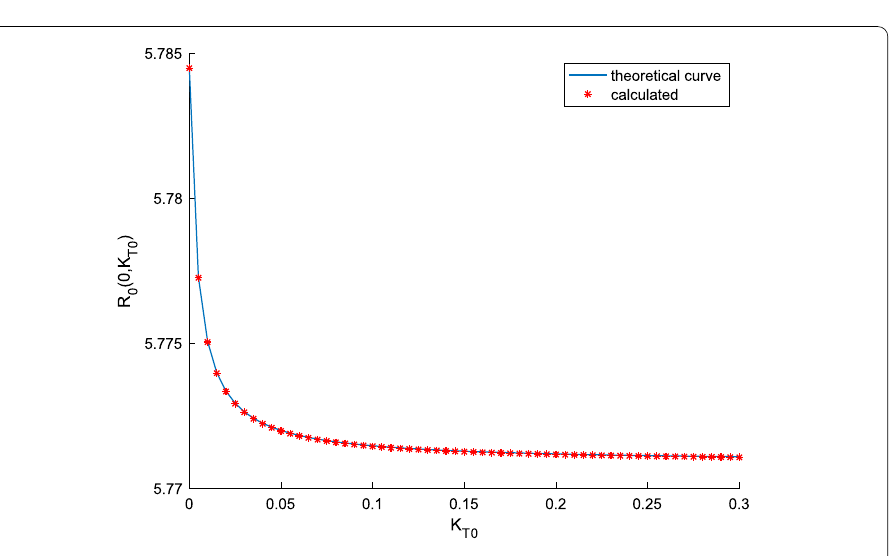
Figure 18 Variation of the basic reproduction number with treatment and without